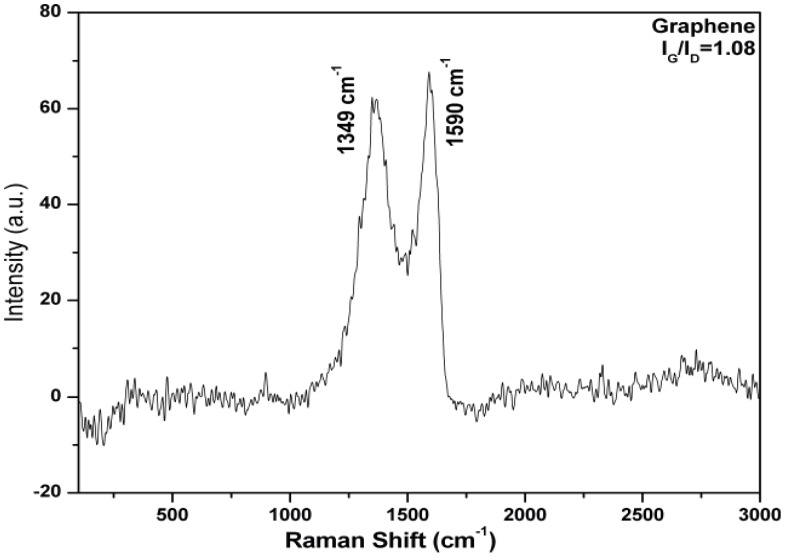
Raman spectra of functionalized graphene.